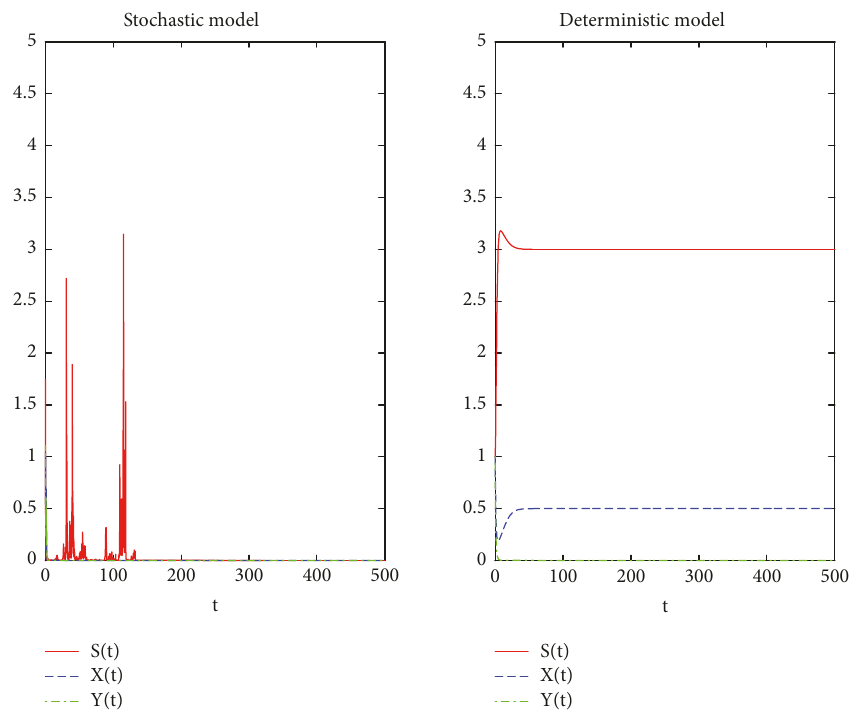
Figure 5: Numerical simulation of the solution of system (2) and its corresponding deterministic system (1) with 𝜎 1 = 1.5, 𝜎 2 = 0.8, 𝜎 3 = 1.0 , with initial value 𝑆(0) = 1, 𝑋(0) = 1, 𝑌(0) = 1 .